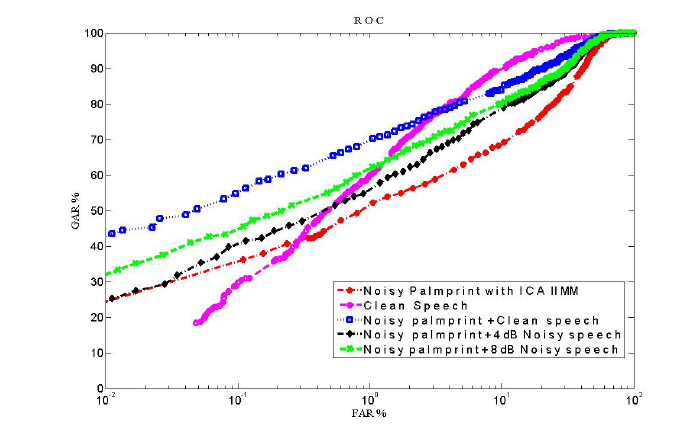
Figure 14. ROC curves for match score level fusion of noisy palmprint using ICA II MM with speech (both clean and